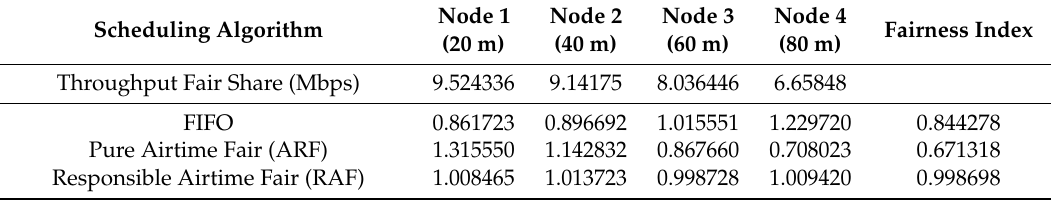
Table 9. Throughput Achieving Ratio and Fairness Index in 802.11ac TCP